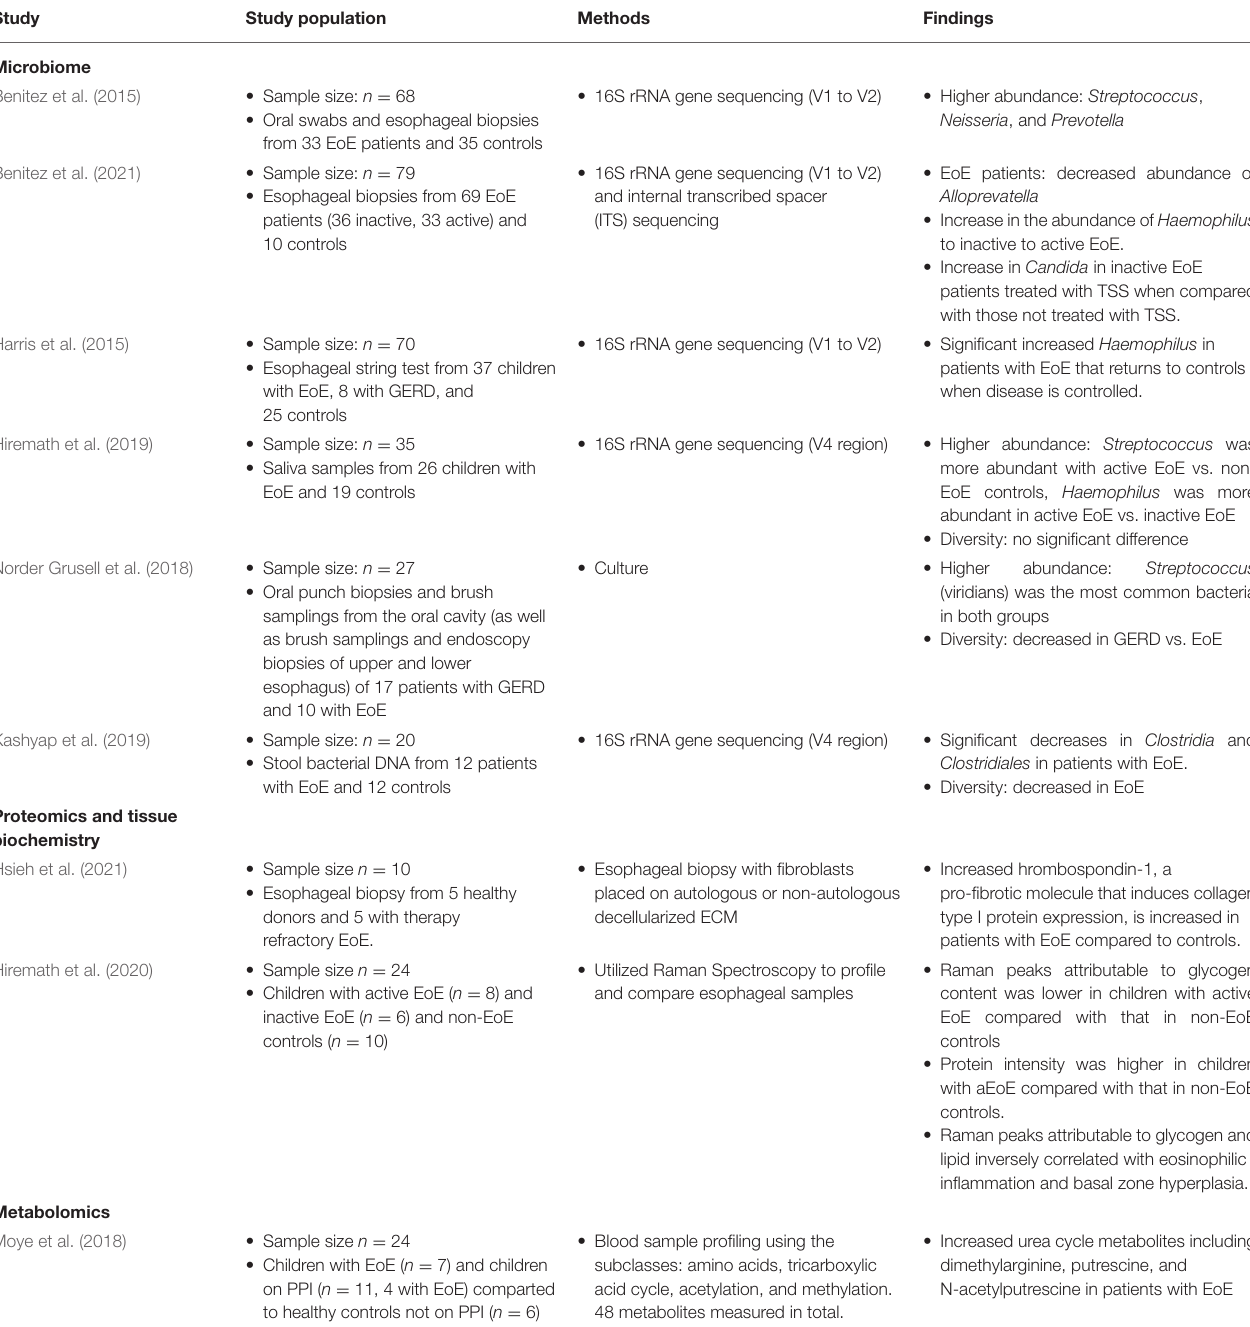
TABLE 1 | Summary of studies applying microbiome analysis in eosinophilic